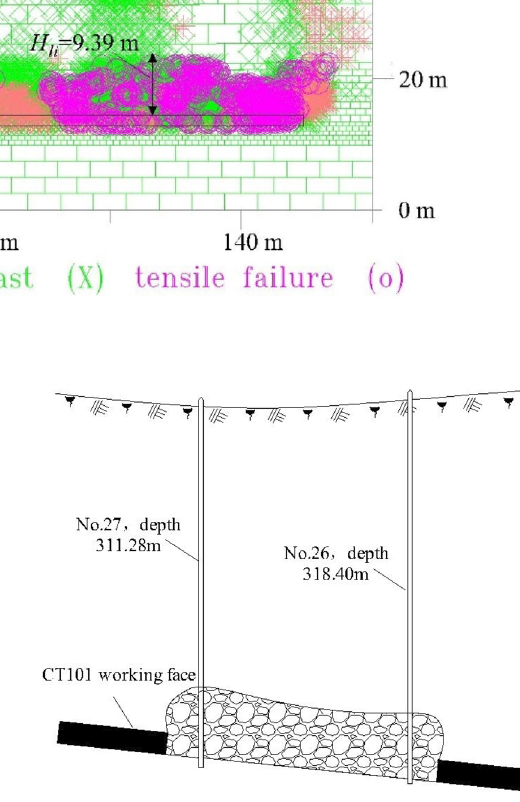
Fig. 7 Location of the two boreholes in panel